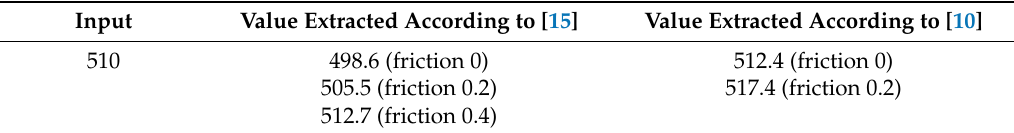
Table 5. Estimates of the Mode II critical energy release rate G II c (J/m 2 ).